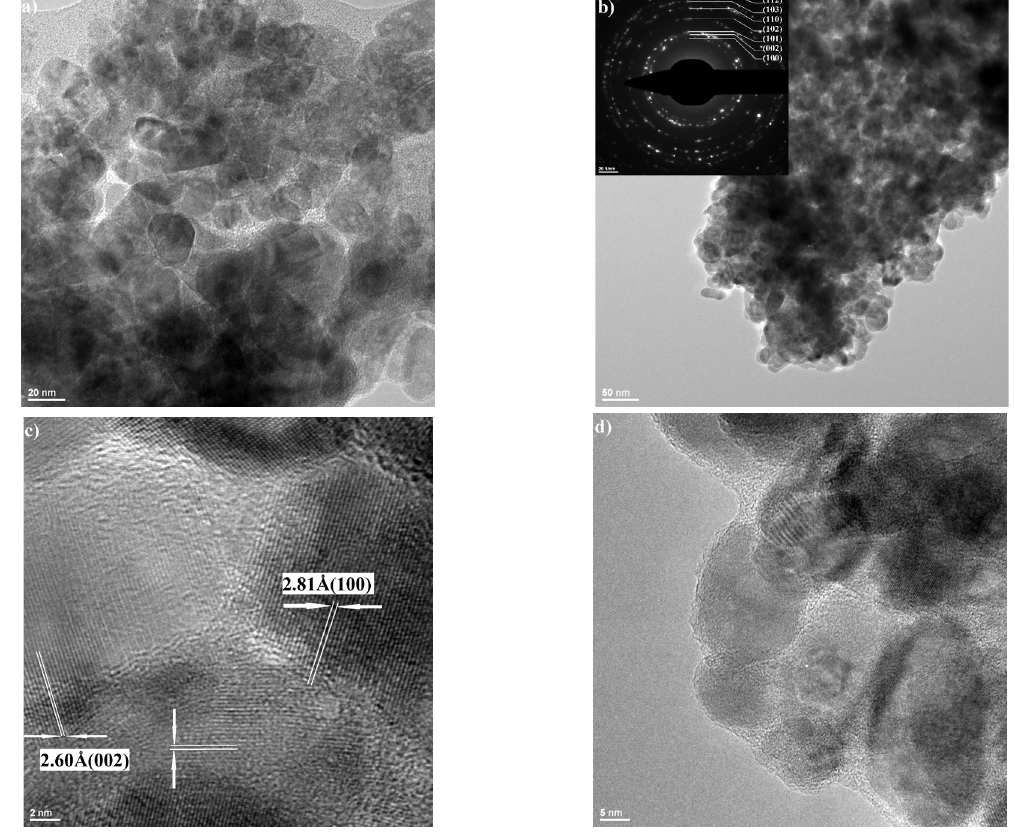
Figure 4. TEM images, SAED patterns and the corresponding HRTEM images for ZnO powders obtained in different media based on ionic liquids - pure